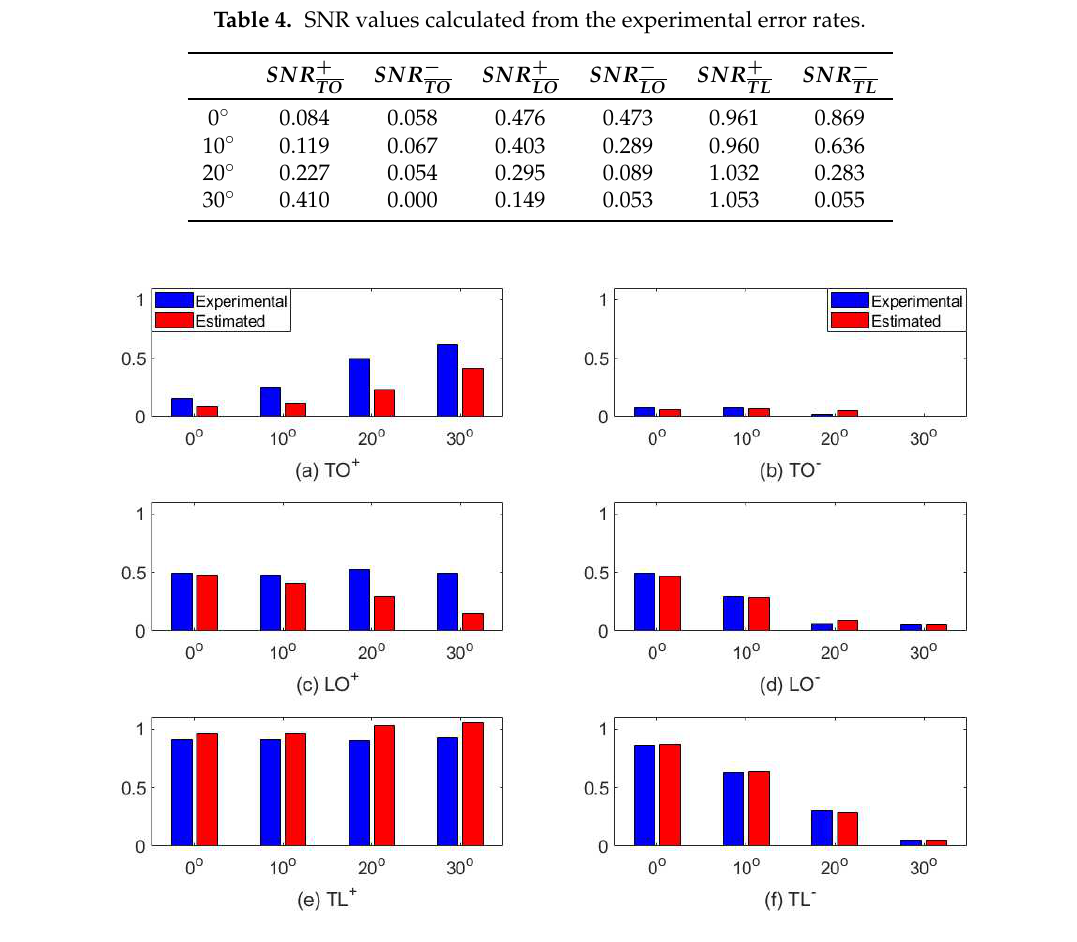
Figure 4. Experimental and estimated SNR values for inward (+) and outward ( − ) cases of the azimuths 0 ◦ , 10 ◦ , 20 ◦ and 30 ◦ : (a) TO + , (b) TO − , (c) LO + , (d) LO − , (e) TL + and (f) TL −